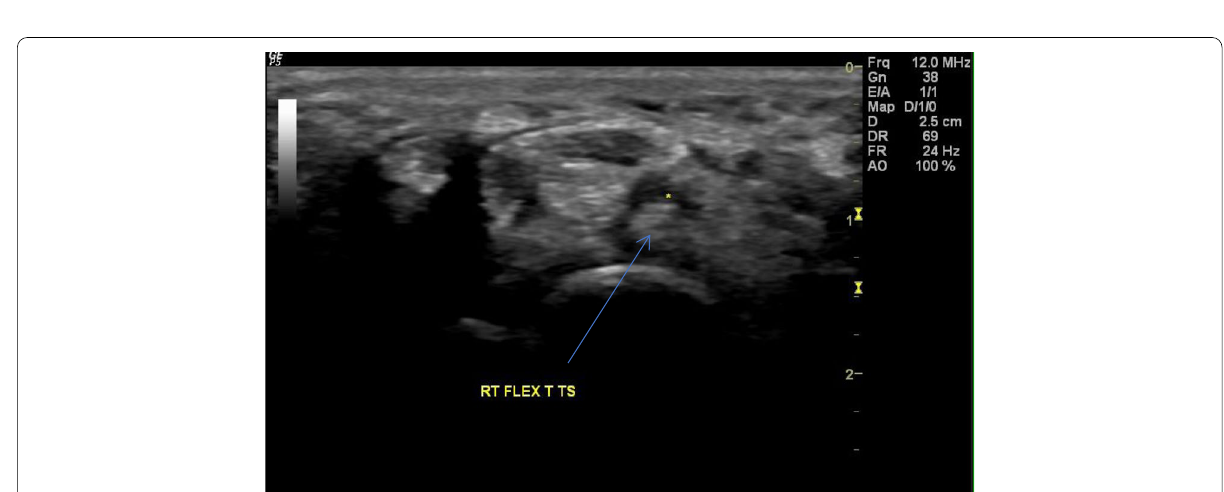
Fig. 1 Ultrasound scan showing gray scale ultrasound transverse palmar scan of the median nerve with flexor tendon below the nerve at the carpal tunnel showing the hypoechoic area surrounding the flexor tendon (blue arrow) indicating flexor tendon (FT) tenosynovitis (yellow